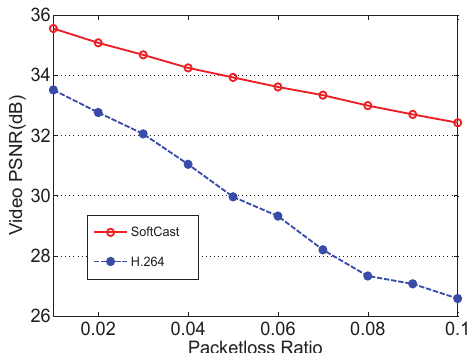
Figure 10: Comparison of resistence to packet loss between SoftCast and H.264.